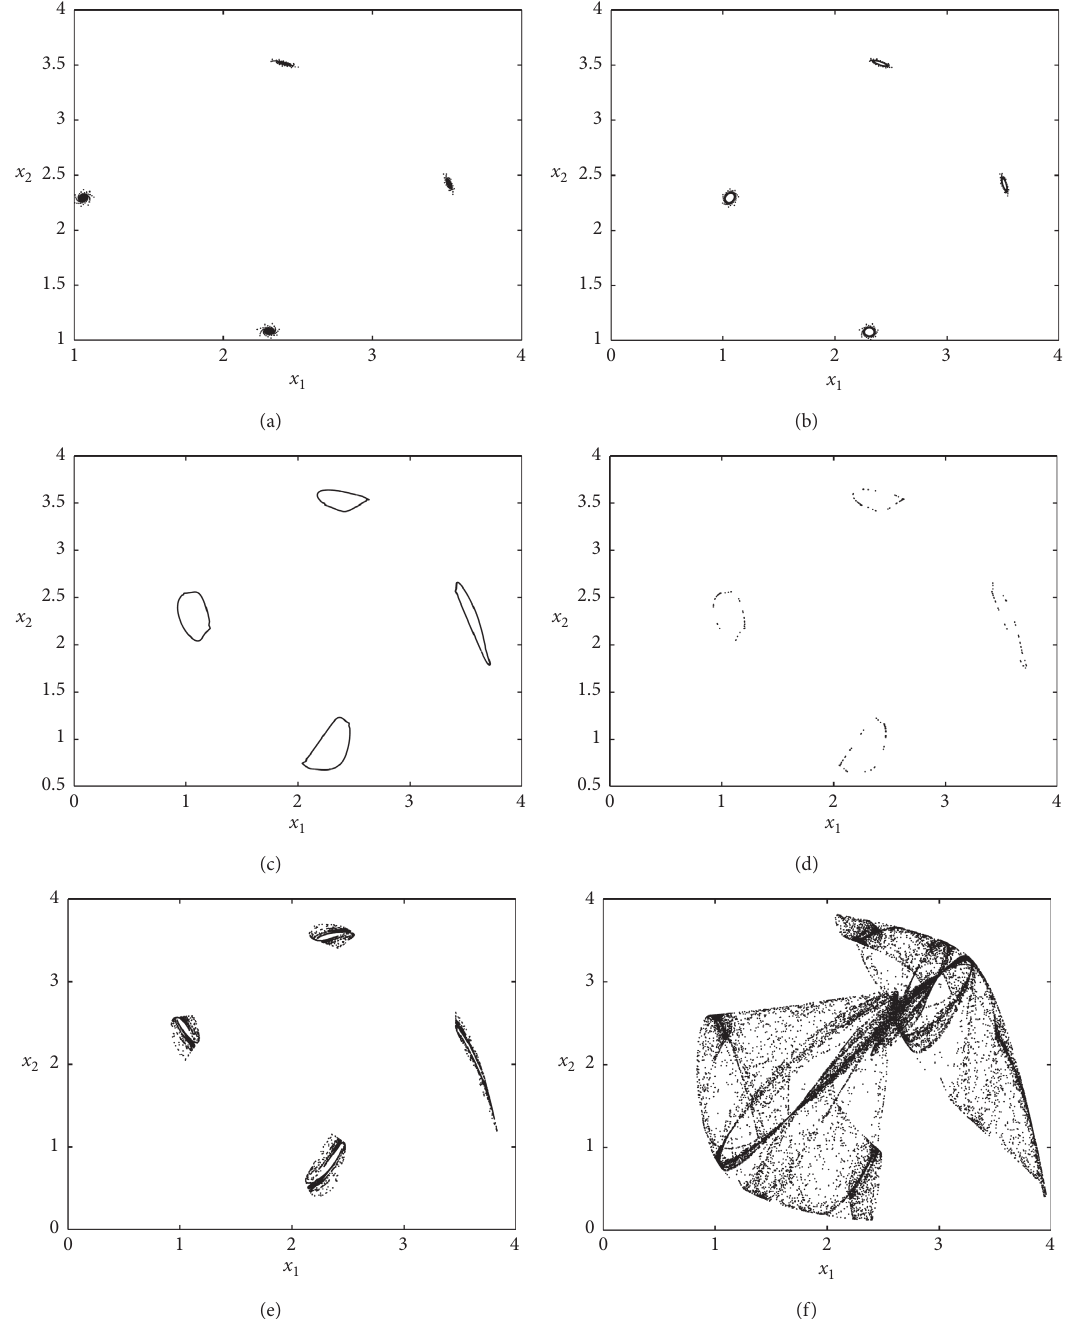
Figure 3: The process of evolution of attractors in system (10). (a) α � 0 . (f) α 2